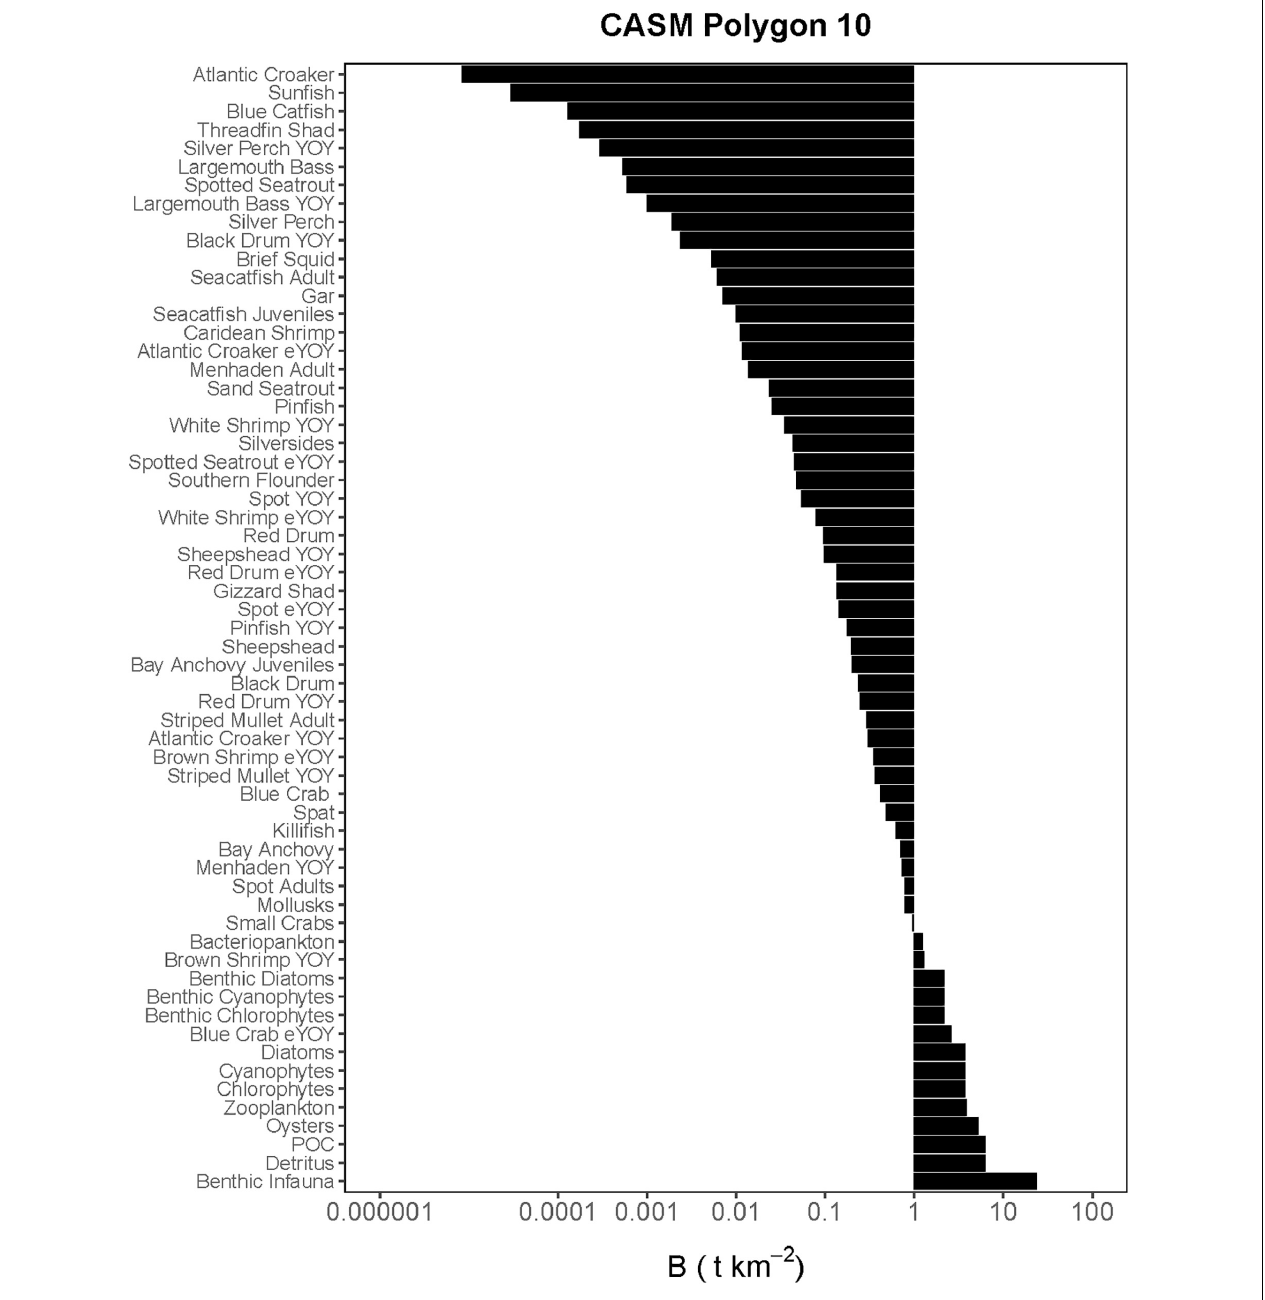
FIGURE 3 | Comprehensive aquatic systems model (CASM) species-biomass distribution for June 15 in polygon 10 (plotted on log